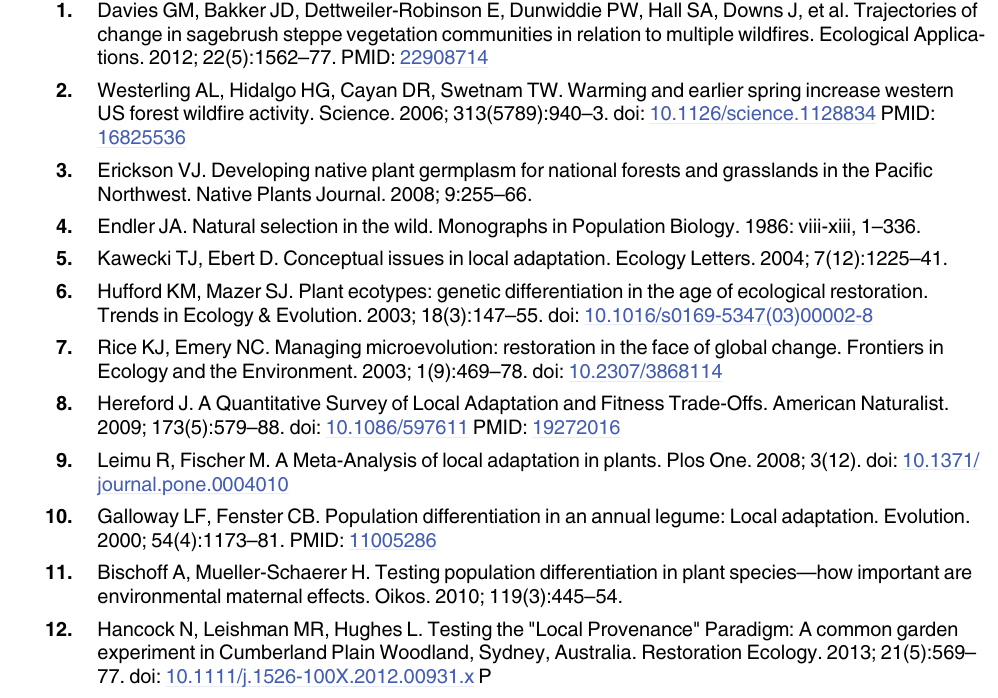
S1 Table. Pearson correlation coefficients between climate variables and plant traits for octoploid (n = 57) and tetraploid (n = 52) basin wildrye source locations. Traits were mea-